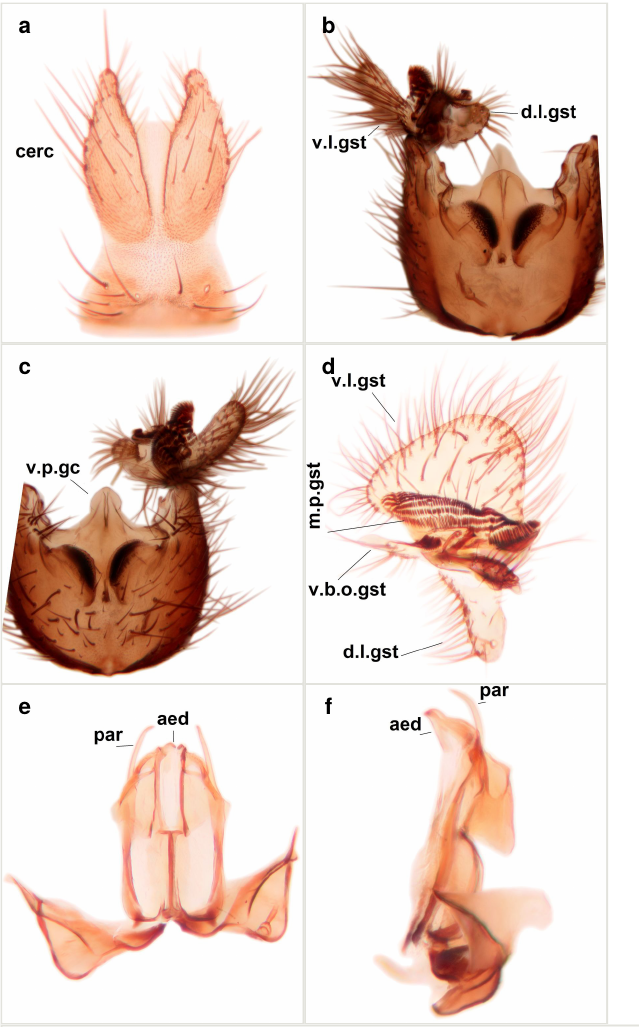
Figure 15. Phronia exigua Zetterstedt, male hypopygium. The specimen (MYCE-JS-2013-0010, JES) is collected from Finland, Lkor: Savukoski, Joutenoja, 16.8.-18.9.2012, J. Salmela leg. Please see Fig. 14 for